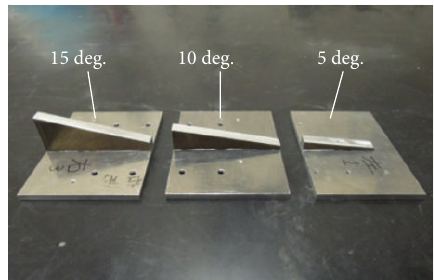
Figure 9: Three wedges for inclination of the footpad.